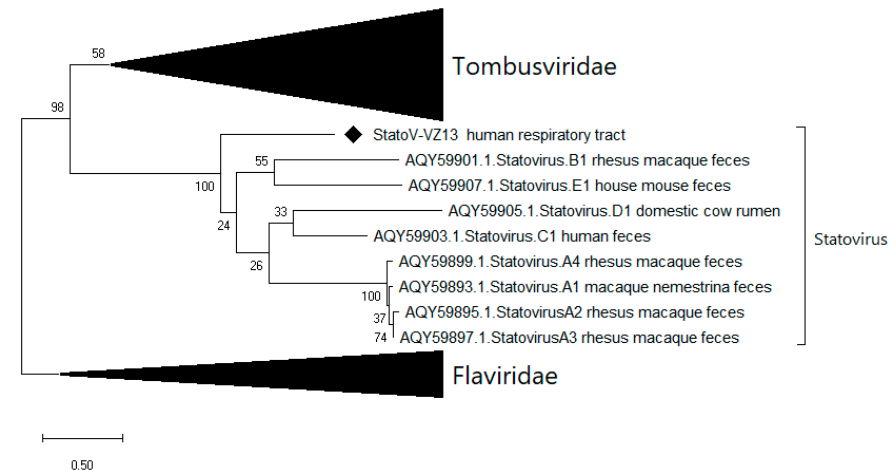
Figure 4. Phylogenetic tree of 249 amino acid partial RNA-dependent RNA polymerase (RdRp) protein sequences of statovirus VIZIONS-2013 (StatoV-VZ13) compared to the statoviruses on GenBank and viruses of the Tombusviridae and Flaviridae family.